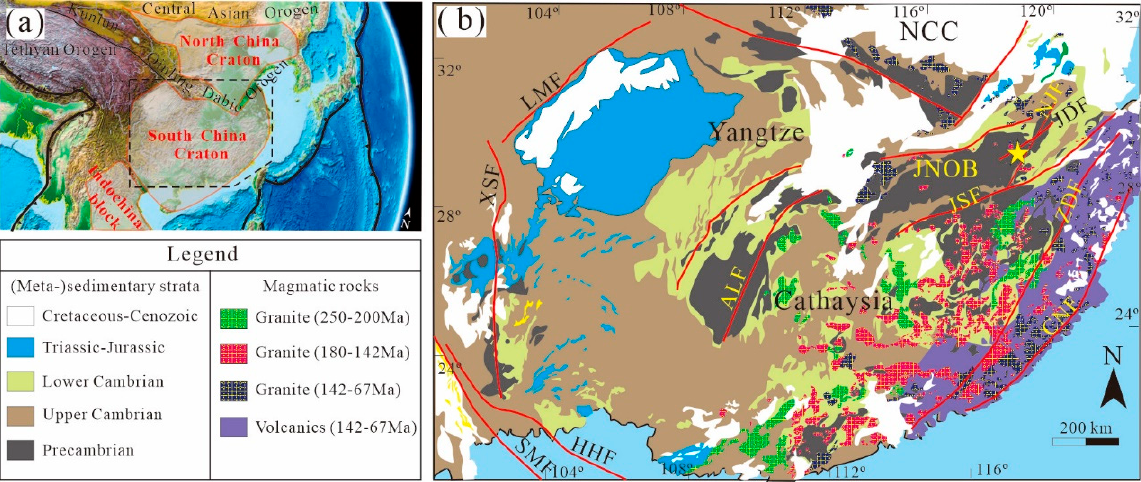
Figure 1. ( a ) A satellite map showing the location of the South China Craton (SCC) and surrounding geologic terrains; ( b ) A geological map showing major lithologies and structures in the Phanerozoic era of SCC (adapted from [34]). AHF: Ailaoshan-Honghe Fault; CNF: Changle-Nanao Fault; JDF: Jingdezhen Fault; JNOB: Jiangnan Orogenic Belt; JSF: Jiangshan-Shaoxing Fault; LMF: Longmenshan Fault; HHF: Honghe Fault; NCC: North China Craton; NJF: Northeast Jiangxi Fault; QDOB: Qingling-Dabie Orogenic Belt; SMF: Song-Ma Fault; XMF: Xiangtan-Miluo Fault; XSF: Xianshuihe Fault: ZDF: Zhenghe-Dapu Fault. The yellow stars mark the location of the Dexing (including Tongchang) porphyry district.